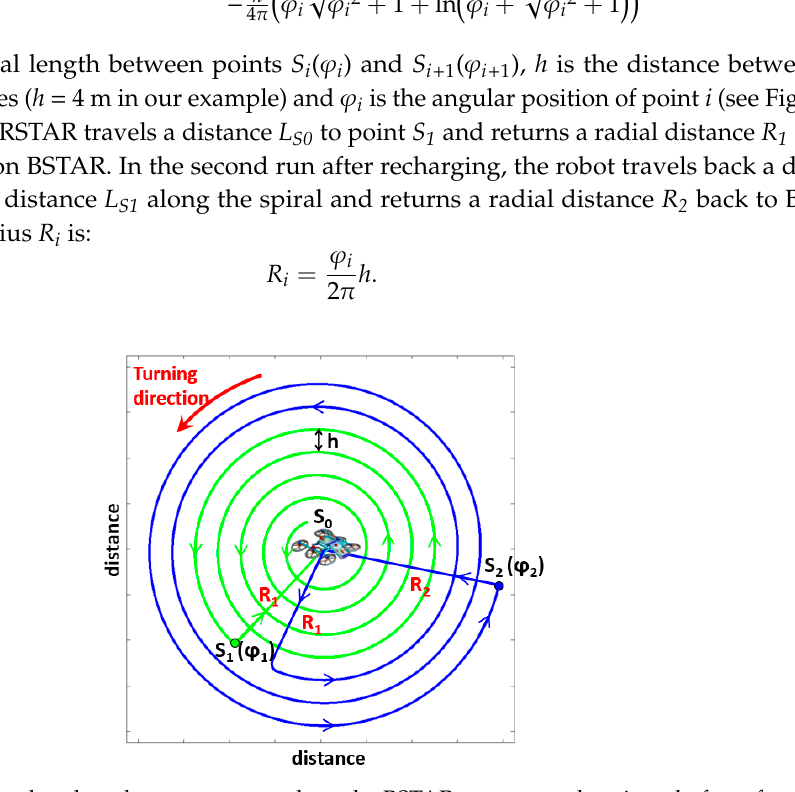
Figure 14. The area that the robots can scout, where the BSTAR acts as a recharging platform for the RSTAR robots. S0 is the recharging point, Si is the stop before returning to